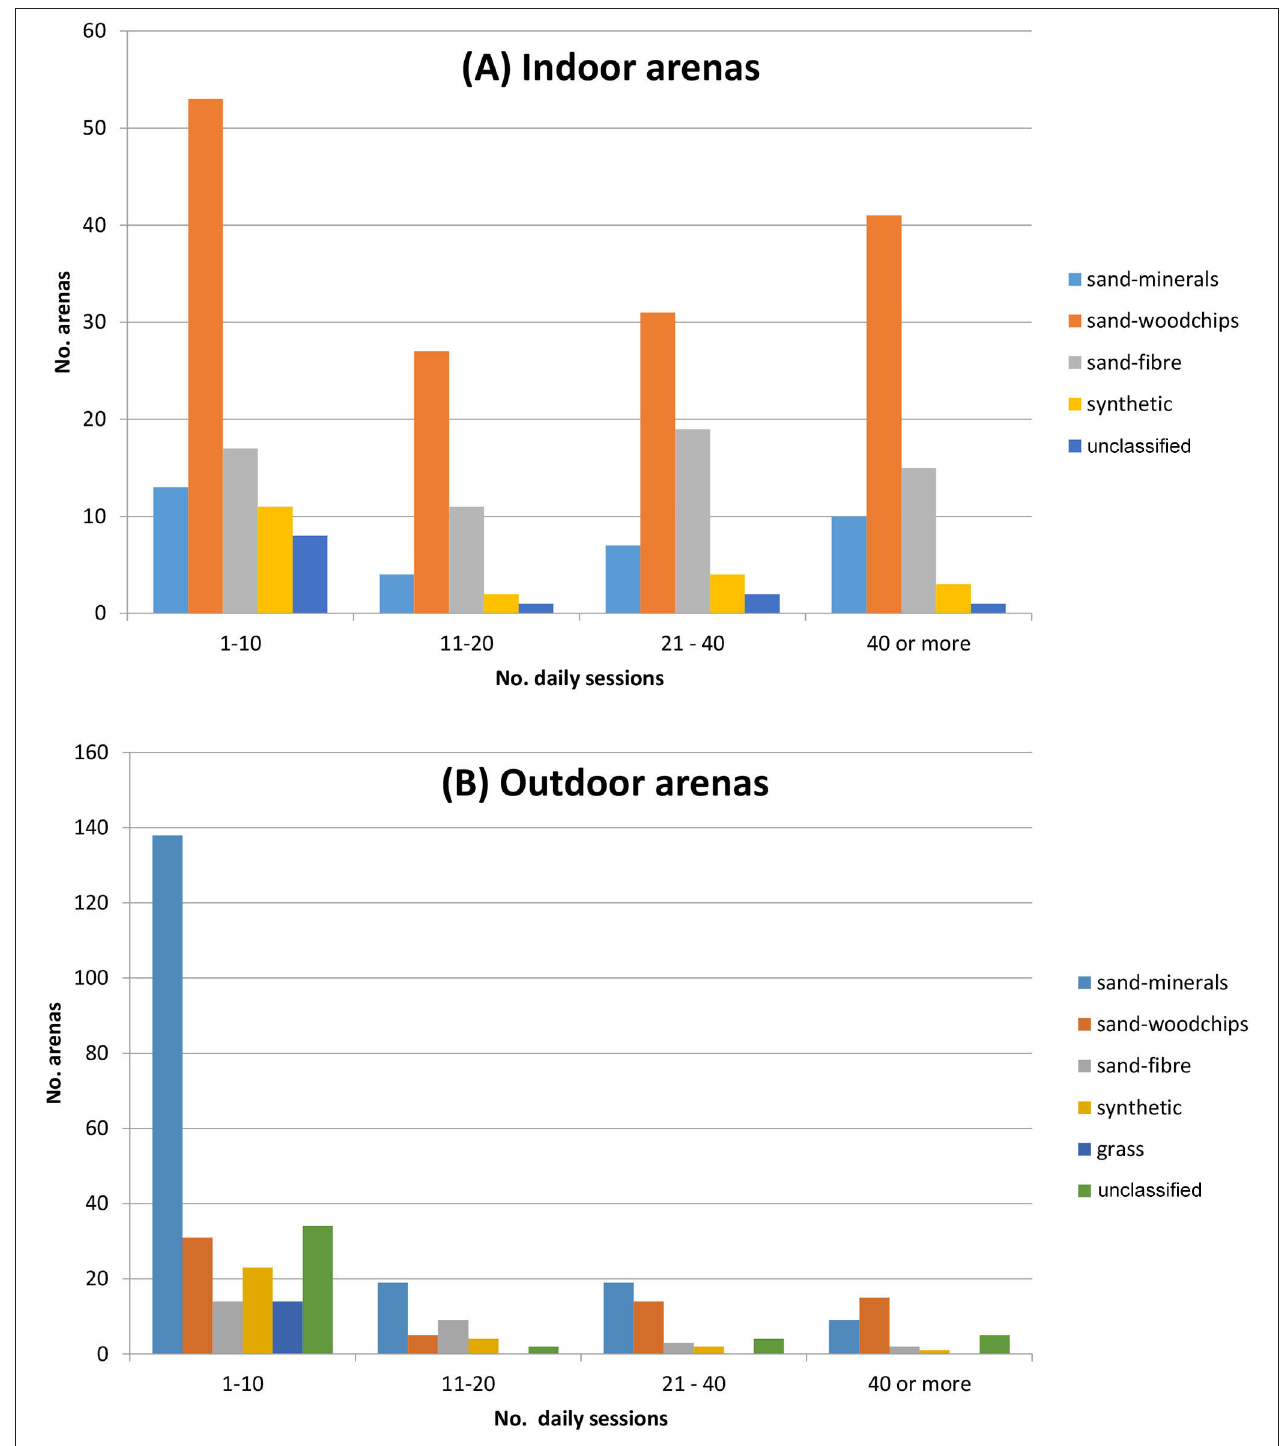
FIGURE 1 | Daily sessions per top-layer in indoor (A) and outdoor (B) arenas. Number of arenas per top-layer category and number of daily sessions (a session defined as 45–60min work from one horse). Data are from 280 indoor and 367 outdoor riding arenas identified in a questionnaire in Sweden 2014.